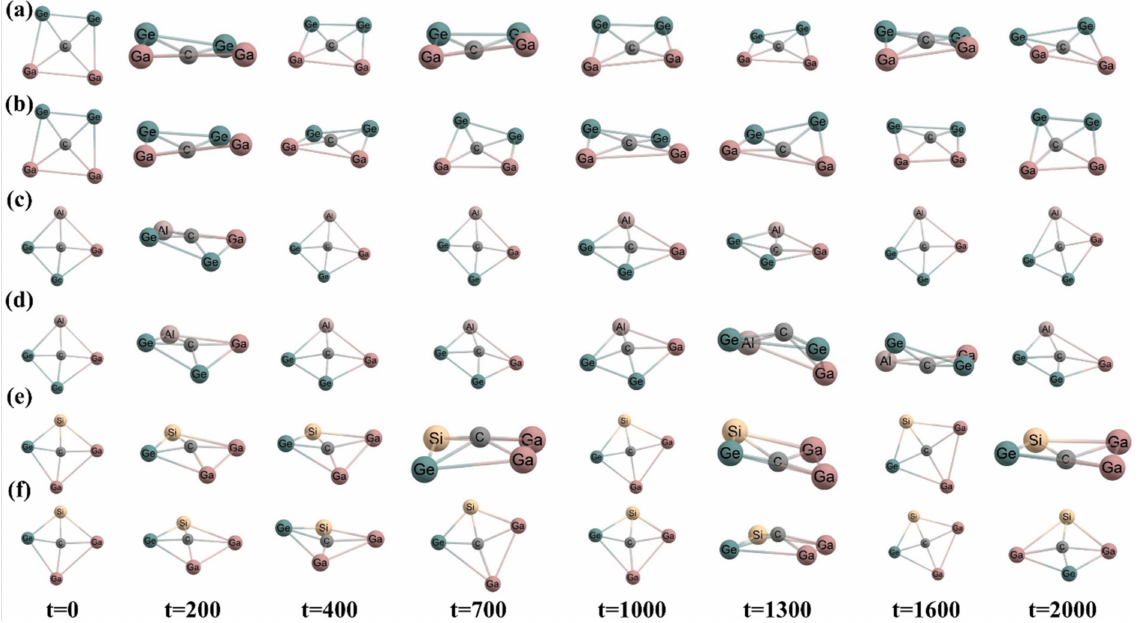
Figure 3. Snapshots at different time steps (time in fs) ( a , c , e ) at 300 K temperature and ( b , d , f ) at 500 K temperature of CGa 2 Ge 2 , CAlGaGe 2 , and CSiGa 2 Ge systems, respectively, in cis geometry.